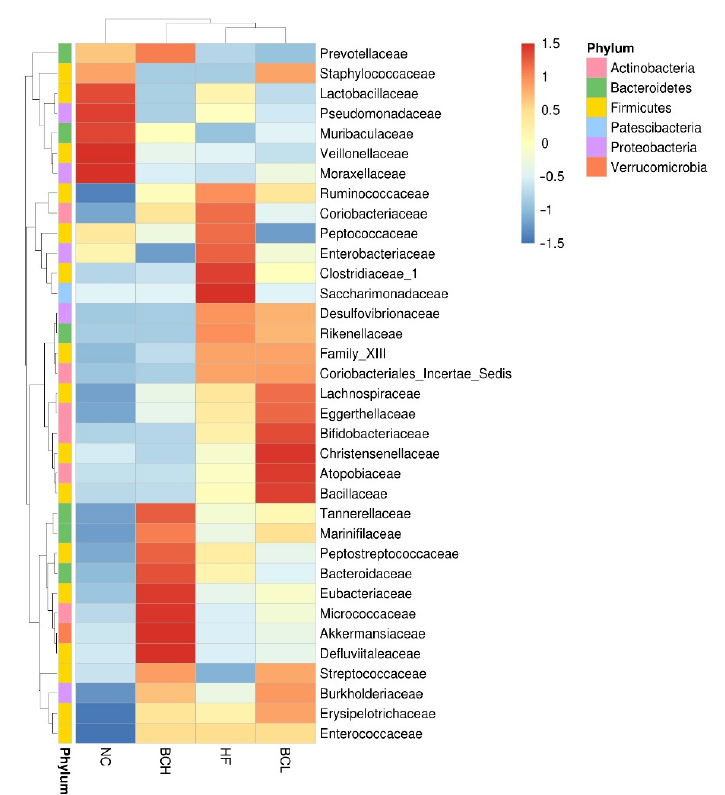
Figure 7. Heatmap analysis for the top 35 relative abundances of bacterial family in fecal samples of rats fed chow diet (NC group), high-fat diet (HF group), high-fat diet + low dose of B. coagulan BACO-17 (7 log CFU/day) (BCL group), and high-fat diet + high dose of B. coagulan BACO-17 (9 log CFU/day) (BCH group) ( n = 5 per group).